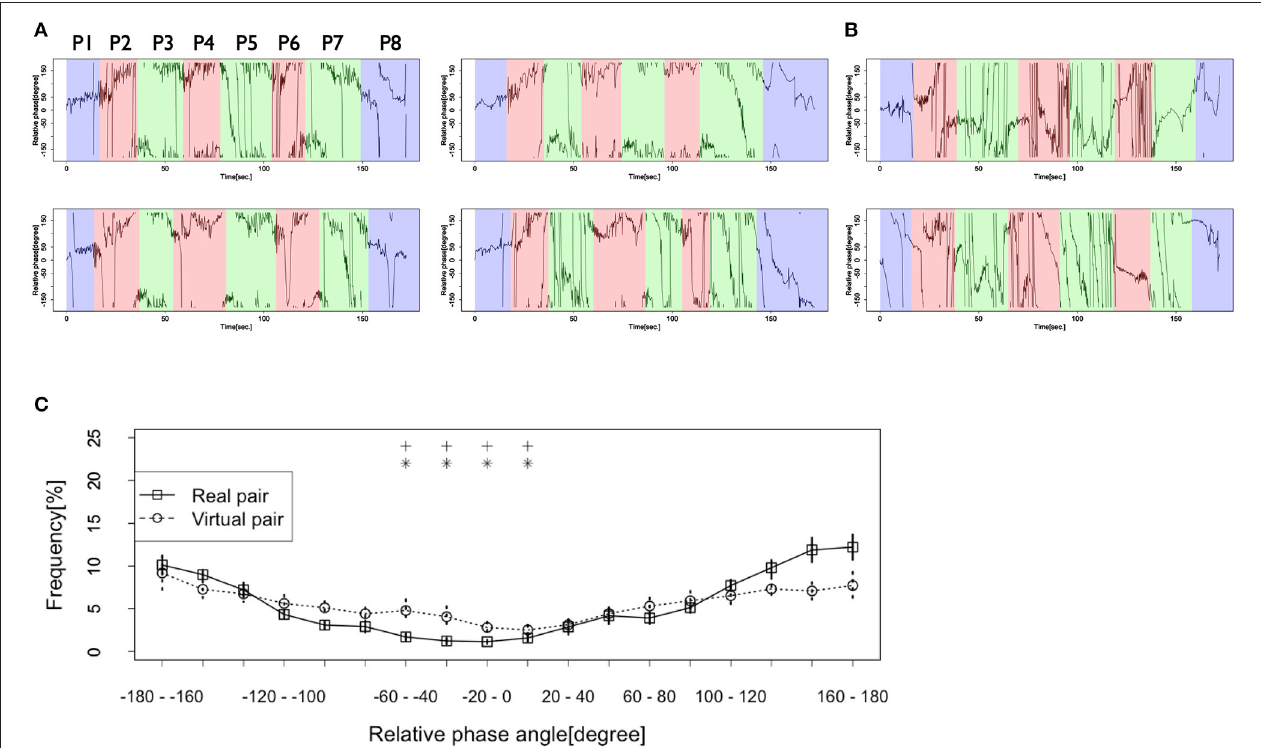
FIGURE 4 | (A) Several examples of the relative phases in the Real pair condition. The spaces colored in blue show the time when both dancers did not show their performances (P1, P8), those colored by red show the performance time of the first dancer (P2, P4, P6), and those colored by green show the performance time of the second dancer (P3, P5, P7). (B) Several examples of the relative phases in the Virtual pair condition. (C) Frequencies of each relative phase of the dancers’ rhythmic movements in the Real pair condition and the Virtual pair condition. Vertical lines at each plot indicate standard error. Asterisk and cross indicate the relative phases whose frequencies show significant differences with that at − 180– − 160 degrees and 160–180 degrees in the Real pair condition (*: p < 0.05 with − 180– − 160 degrees, + : p < 0.05 with 160–180